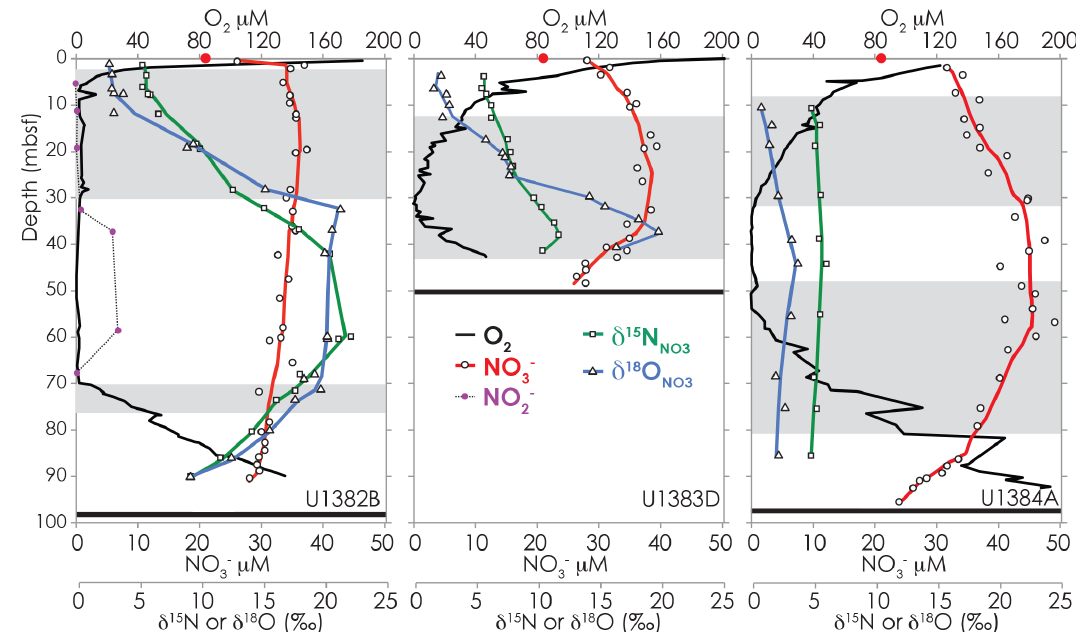
Figure 2. Depth profiles from IODP sites U1382B, U1383D, and U1384A at North Pond of porewater concentrations of O 2 (from Orcutt et ) . The red circle at the top of the profiles al., 2013) and NO − as well as the N and O isotopic composition of NO − ( δ 15 N NO and δ 18 O − 3 3 NO 3 3 denotes the bottom seawater NO − concentration of 21.6µM (Ziebis et al., 2012). Horizontal black lines indicate depth of contact with 3 ocean crust. Gray boxes indicate “transitional” zones in which a reaction–diffusion model is used to calculate co-occurring nitrification and denitrification (see text for details). Strong increases in δ 15 N and δ 18 O in U1382B coincide with depths having the lowest O 2 concentration and are indicative of the influence of denitrification. While the NO − concentrations profiles of U1383D and U1384A appear similar, stark 3 differences in the nitrate dual isotopic composition reflect the generally low level of microbial activity in